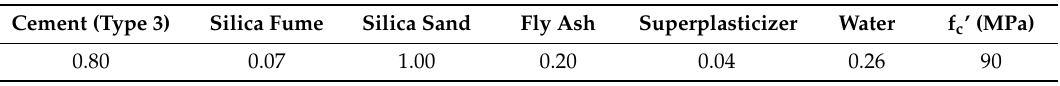
Table 1. Composition of mortar matrix and its compressive strength.